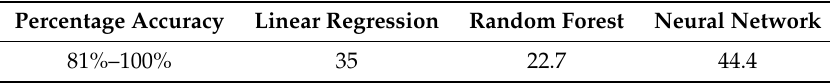
Table 3. The prediction accuracy for left-turning